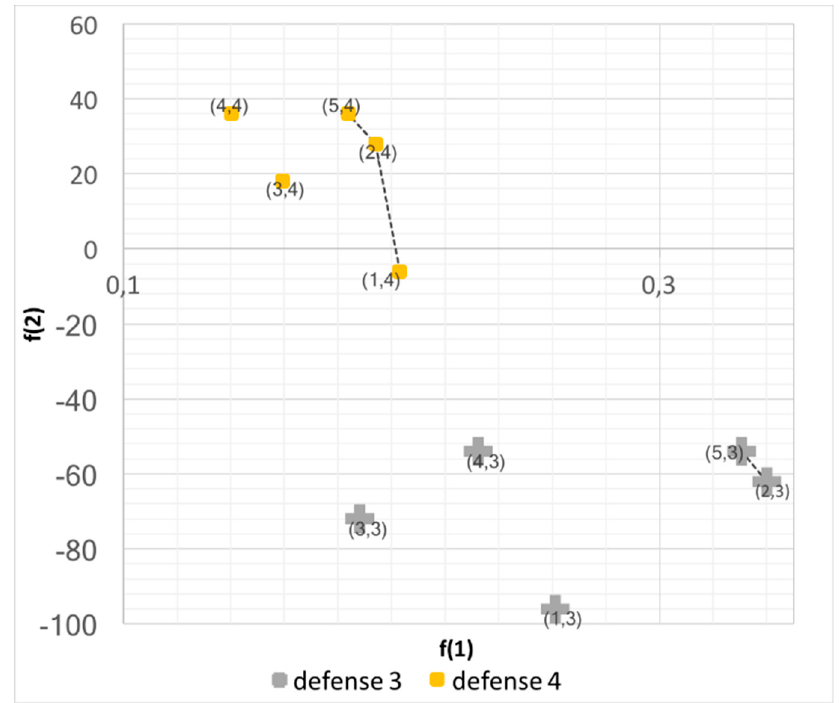
Figure 10. Target space with remaining Pareto fronts.